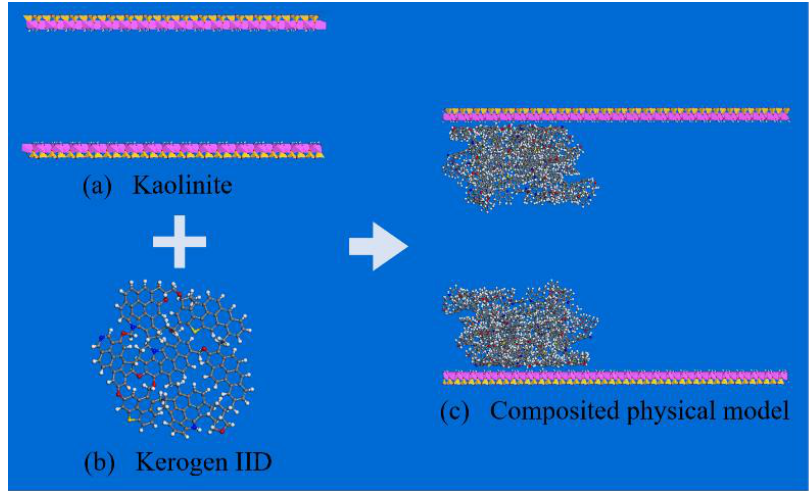
Figure 1. The composite shale model of kaolinite and kerogen IID.